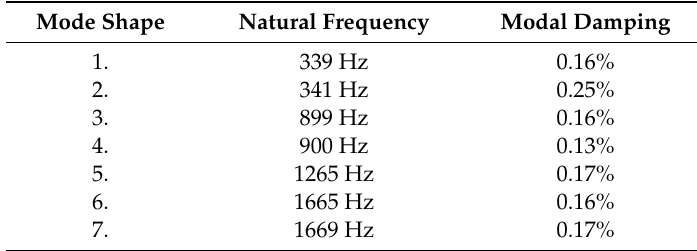
Table 4. Parameters of the modal model of the steel–polymer concrete